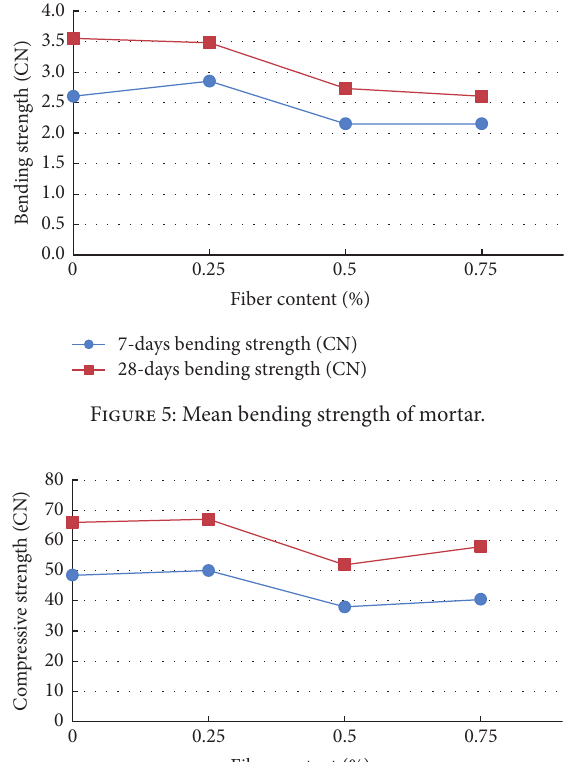
Figure 4: Mean number of cracks on the surface of mortar after 24 hours.